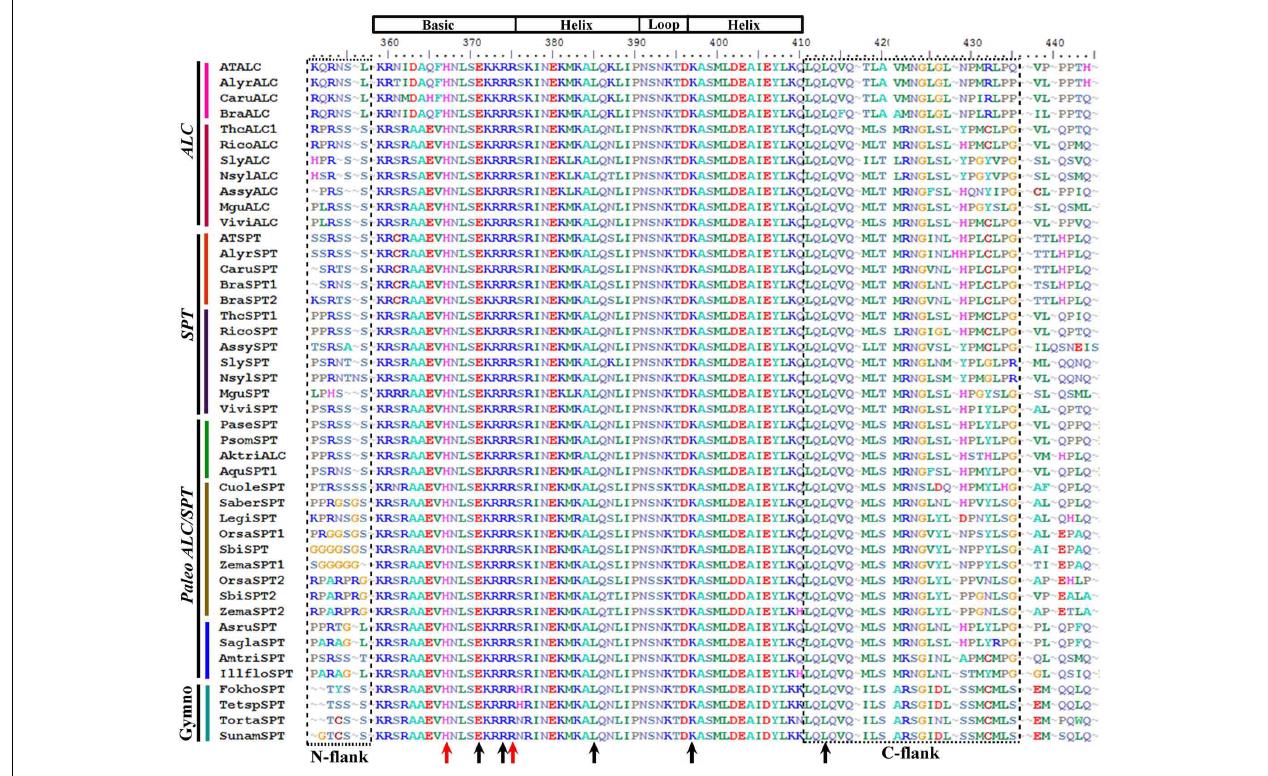
FIGURE 6 | Alignment of the bHLH domain of SPATULA/ALCATRAZ proteins (labeled with the clade names they belong to). Colors to the left of the sequences indicate the taxon they belong to as per color conventions in Figure 7 . The bHLH was drawn based on Toledo-Ortiz et al. (2003) and in our alignment corresponds with positions K359-Q410. The alignment shows an N-flank before the start of the bHLH domain rich in Serine (S). Within the bHLH domain, black arrows indicate positions E13,